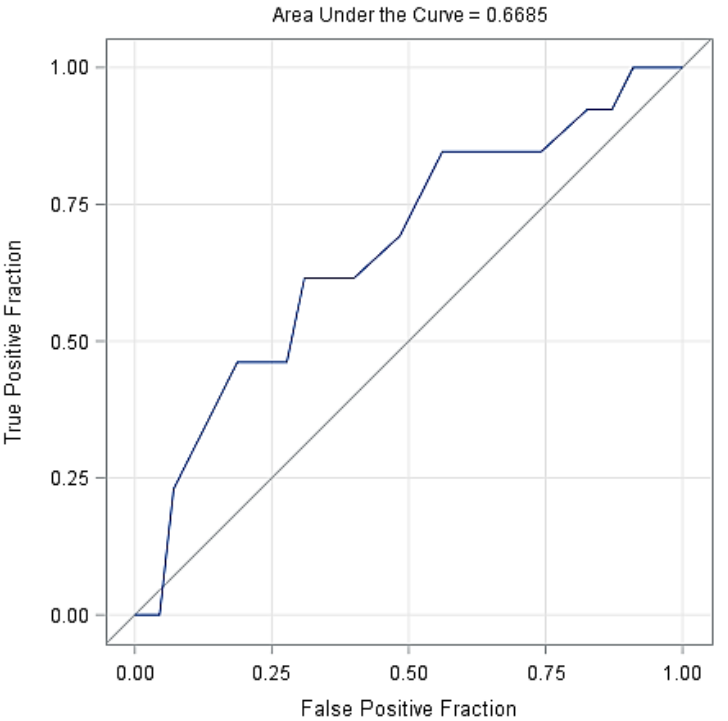
Figure 3. The receiver operating characteristic curve (ROC) of the model at various decision thresh- olds with the AUC of the model.